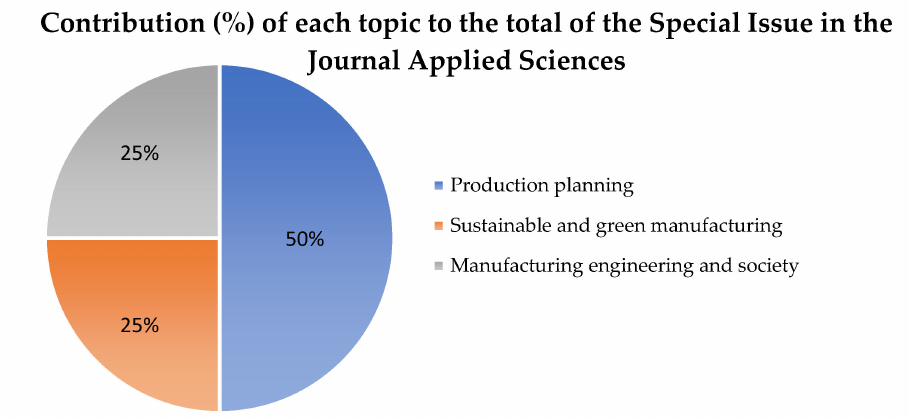
Figure 2. Contribution (%) of each topic to the Special Issue in the journal Applied Sciences